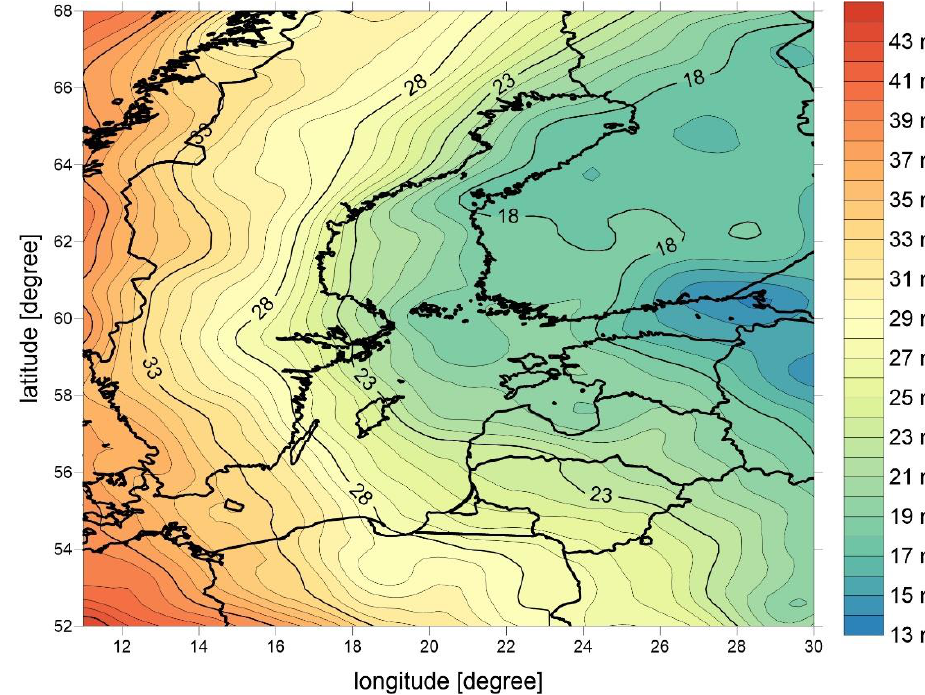
Figure 9. The final model of quasigeoid, in meters, from the GOCO model.